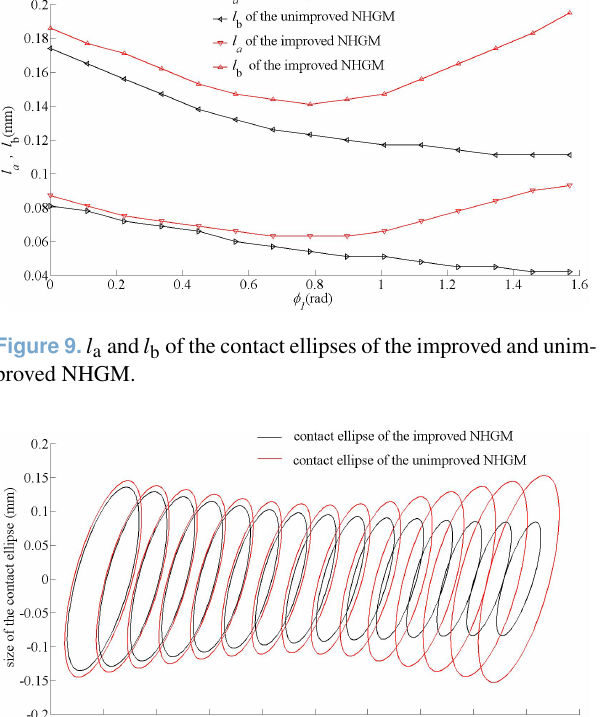
Figure 8. Maximum contact stress calculated by the finite element method, where ϕ 1 = 0 . 25 π .